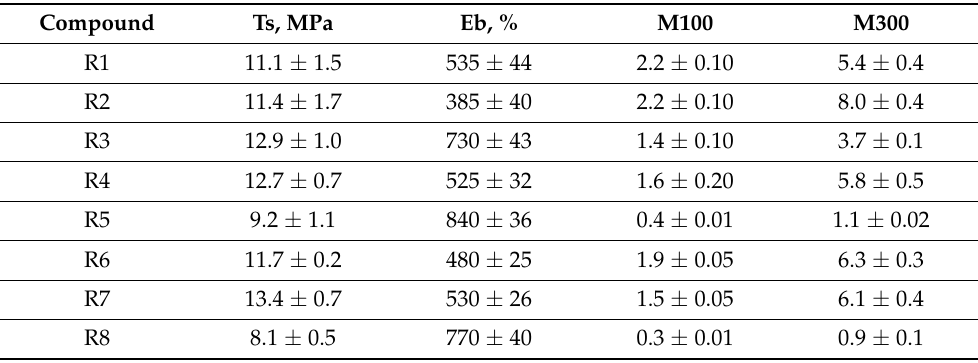
Table 4. Mechanical properties of the studied compounds.